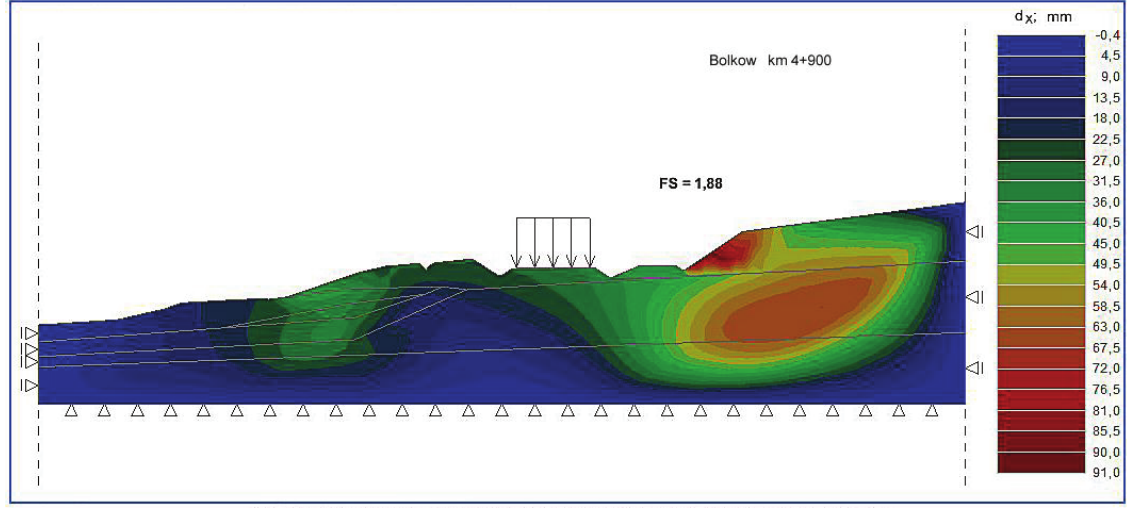
= 1.88. Figure 10. Phase 2 of calculations – stability analysis of the upper part of the slope above the min = 1.88 road excavation, F min = 1.88 road excavation, F min